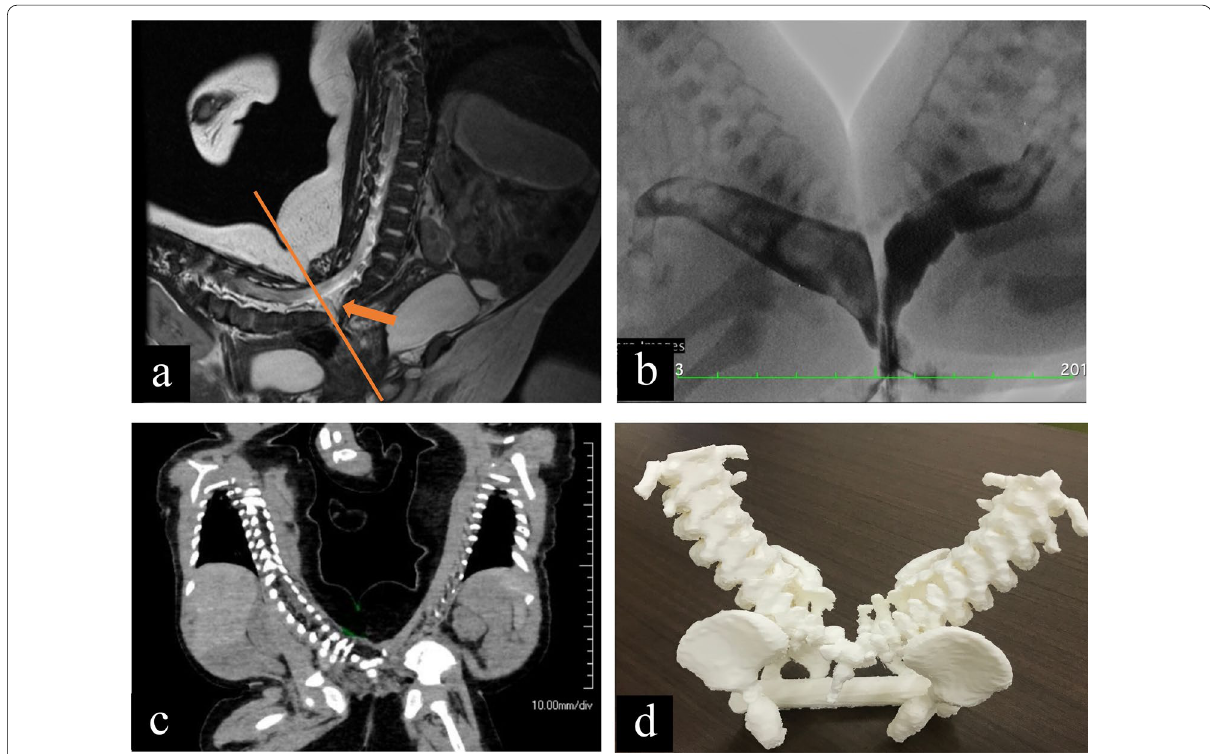
Fig. 2 Preoperative image findings and the 3D model. Preoperative image of a a fused spinal cord detected by MRI (arrow), b separated rectums detected by a gastro-graphin enema. c Other intra-abdominal organs have no connection, d the 3D model was created for multidisciplinary